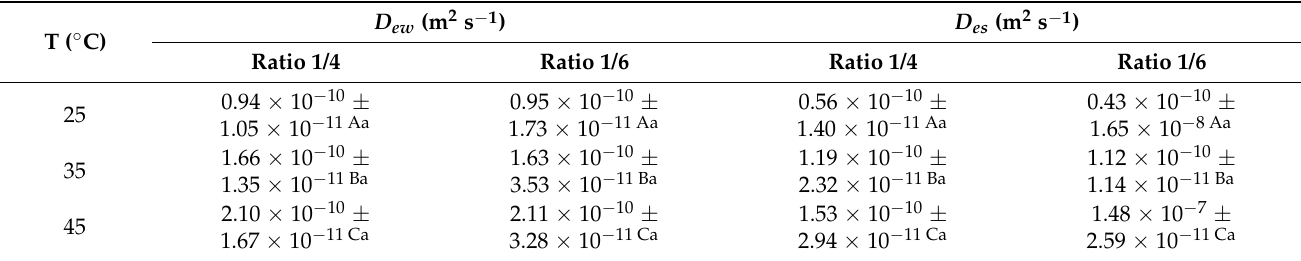
± represents the standard error of nonlinear regression analysis. Different superscripts indicate significant different means ( p < 0.05) within different temperatures (letters in capital) or between the different ratios ( w s / w OD ) (small